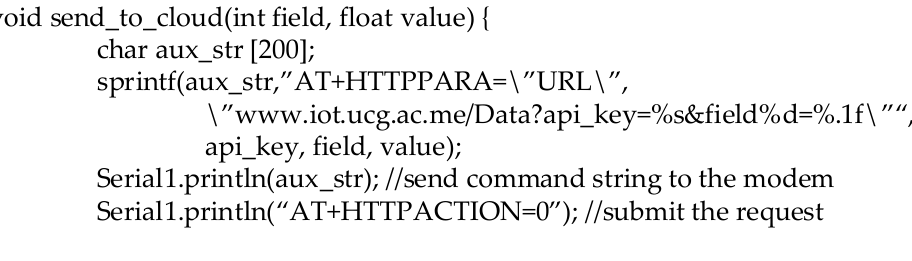
Figure 6. C function for sending data to the cloud.